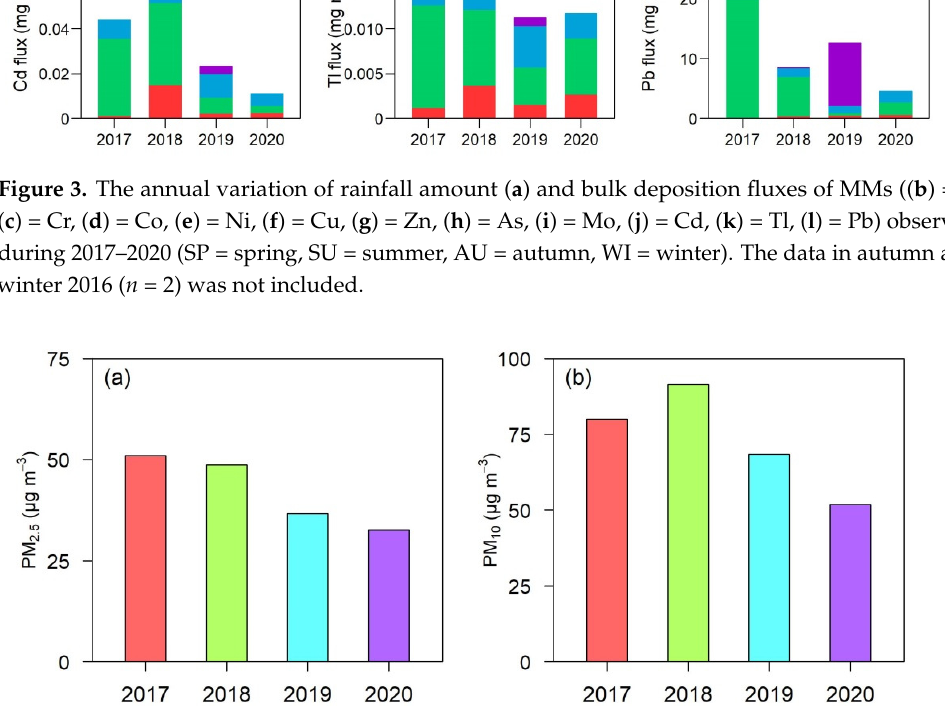
Figure 4. The annual mean concentrations of particulate matter with aerodynamic diameter less than 2.5 μ m ( a ) and 10 μ m ( b ) observed at a nearest monitoring station during 2017–2020 (data 2.5 µ m ( a ) and 10 µ m ( b ) observed at a nearest monitoring station during 2017–2020 (data source: source: http://113.108.142.147:20035/emcpublish/, accessed on 31 December 2020). http://113.108.142.147:20035/emcpublish/, accessed on 31 December